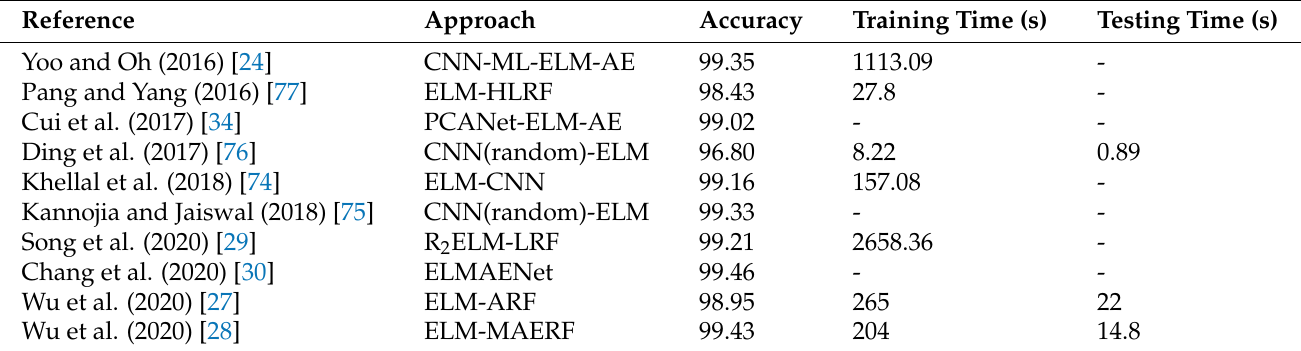
Table 15. Results obtained by CELM architectures for handwritten digit recognition in the MNIST dataset.